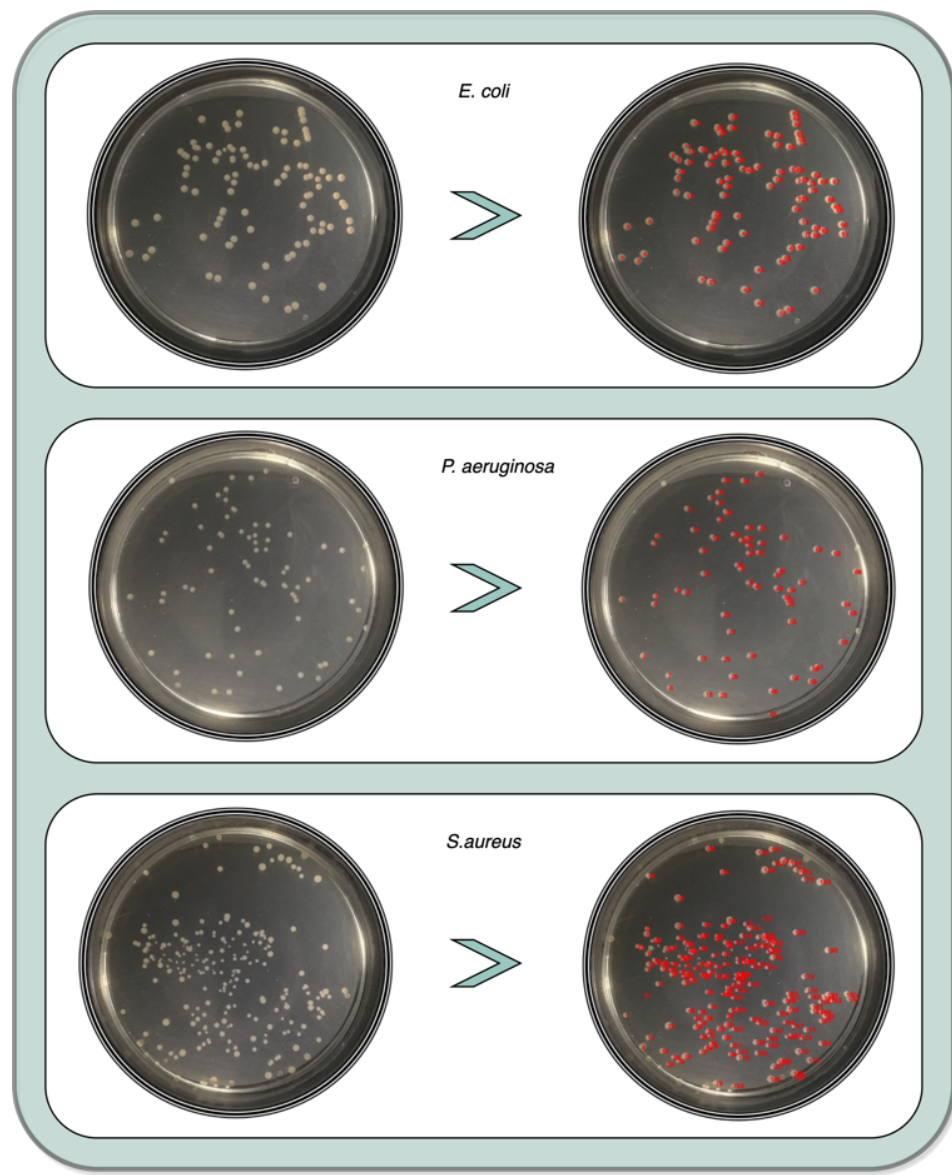
Figure 20. Enumerated example for the 3 colony study